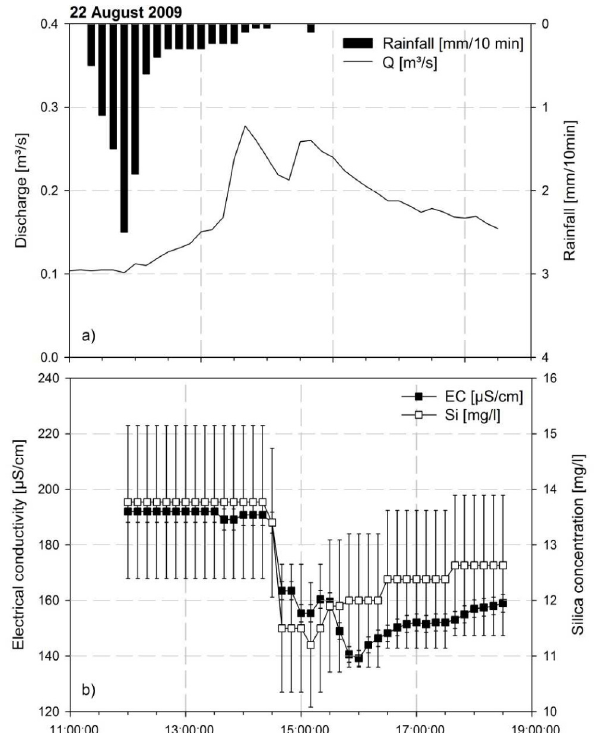
Fig. 5. Event on 22 August 2009 (E4) showing (a) rainfall and dis- charge and (b) EC values and silica. Error bars indicate measure- ment uncertainty of 2% for EC and 10% for silica.